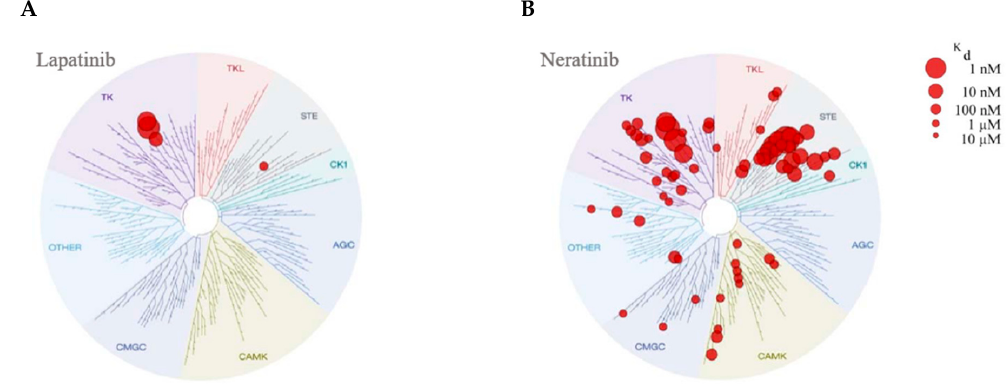
Figure 3. KINOME scans ® (Eurofins DiscoveRx, San Diego, CA, USA) of ( A ) lapatinib and ( B ) neratinib. Each red circle indicates a kinase found to bind to the drug. Larger circles indicate higher affinity interactions. Interactions with K d < 3 μ M are shown. Reprinted by permission from Springer Nature: Nature Biotechnology (Comprehensive analysis of kinase inhibitor selectivity, Davis MI, et al., copyright 2011 [7]). K d , equilibrium dissociation constant.